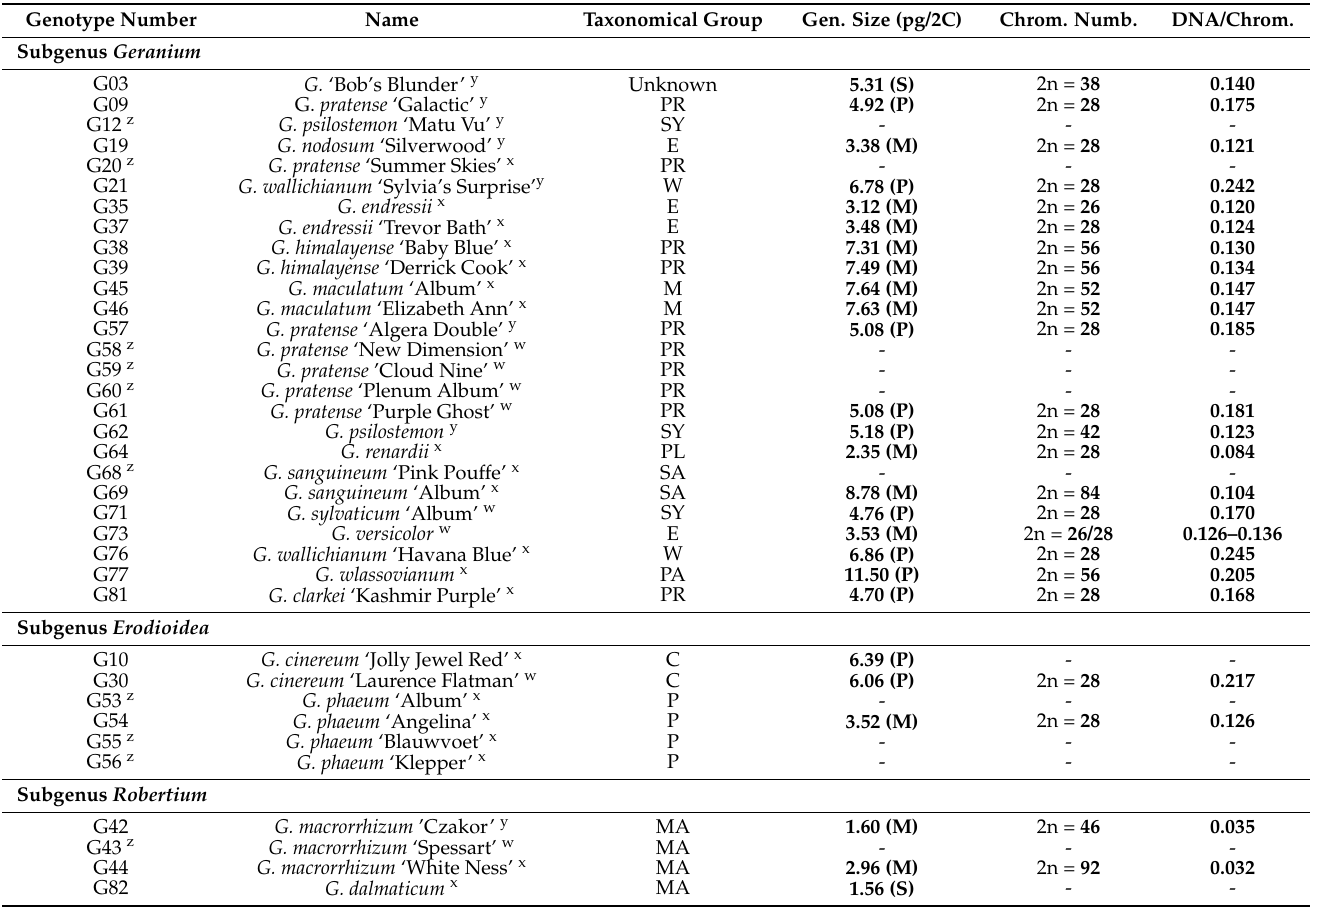
Table 1. List of all commercial cultivars and wild genotypes per subgenus included in the collection of Geranium and their genome sizes (Gen. size (pg/2C)), chromosome numbers (Chrom. numb.) and DNA/chromosome (DNA/chrom. (pg/chromosome)) (divided into taxonomical groups according to Yeo [7]). The plant species used as internal standard is mentioned with the genome size ( Zea mays (M), Pisum sativum (P) and Glycine max (S)). The abbreviations for the taxonomical groups are the following: C = Cinereum, E = Endressii, M = Maculatum, MA = Macrorrhizum, P = Phaeum, PA = Palustre, PL = Platypetalum, PR = Pratense, SA = Sanguineum, SE = Sessiliflorum, SY = Sylvaticum, W =